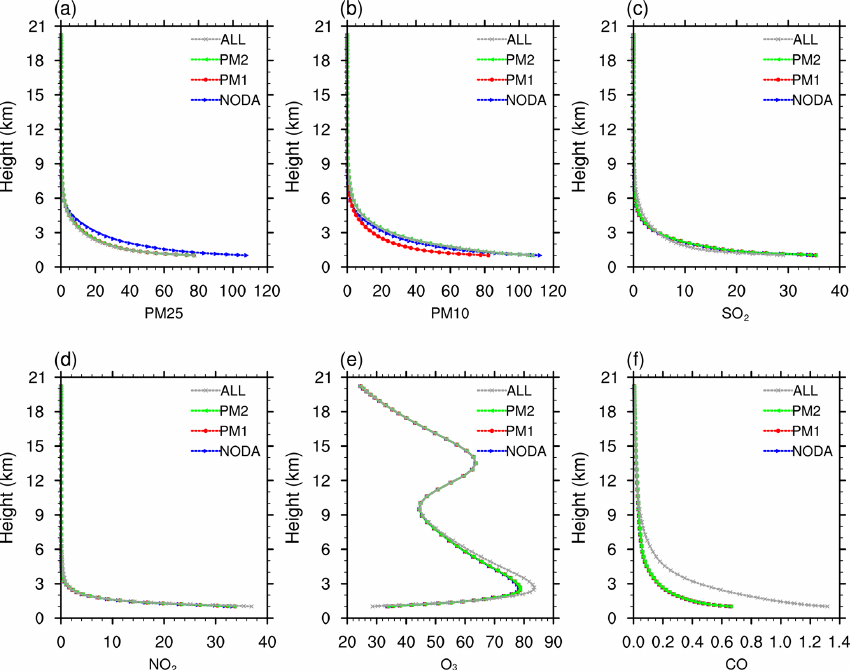
Figure 5. Vertical profile of the analysis at 00:00UTC over 1–31 January 2017 for (a) PM 2 . 5 , (b) PM 10 , (c) SO 2 , (d) NO 2 , (e) O 3 , and (f) CO in different experiments, averaged over the 531 surface stations in China. The blue, red, green, and gray lines denote the results of experiment NODA, PM1, PM2, and ALL, respectively. Units of the y axis are micrograms per cubic meter in (a–e) and milligrams per cubic meter in (f) .